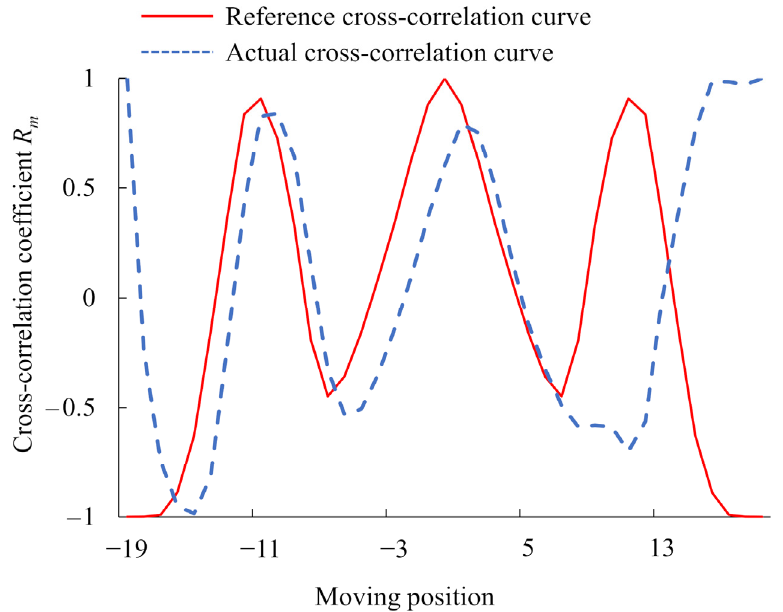
Figure 4. Reference cross-correlation curve and actual cross-correlation curve (Location: 37°55 ′ 9.17 ″ N, 116°18 ′ 4.81 ″ E).